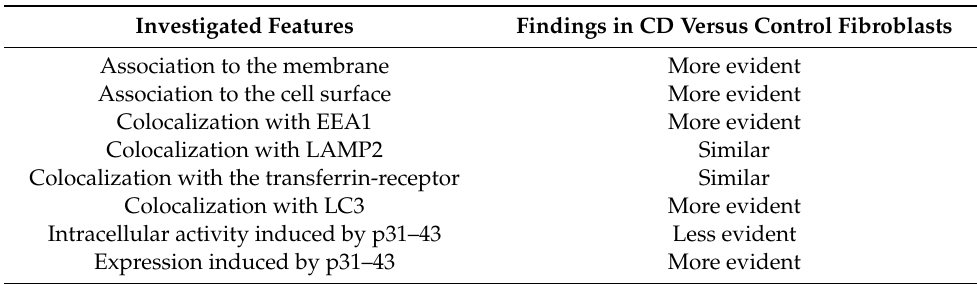
Table 1. Summary of di ff erential features regarding TG2 in CD and control cultures of primary skin-derived fibroblasts. Investigated Features Findings in CD Versus Control Fibroblasts Association to the membrane More evident Association to the cell surface More evident Colocalization with EEA1 More evident Colocalization with LAMP2 Similar Colocalization with the transferrin-receptor Similar Colocalization with LC3 More evident Intracellular activity induced by p31–43 Less evident Expression induced by p31–43 More